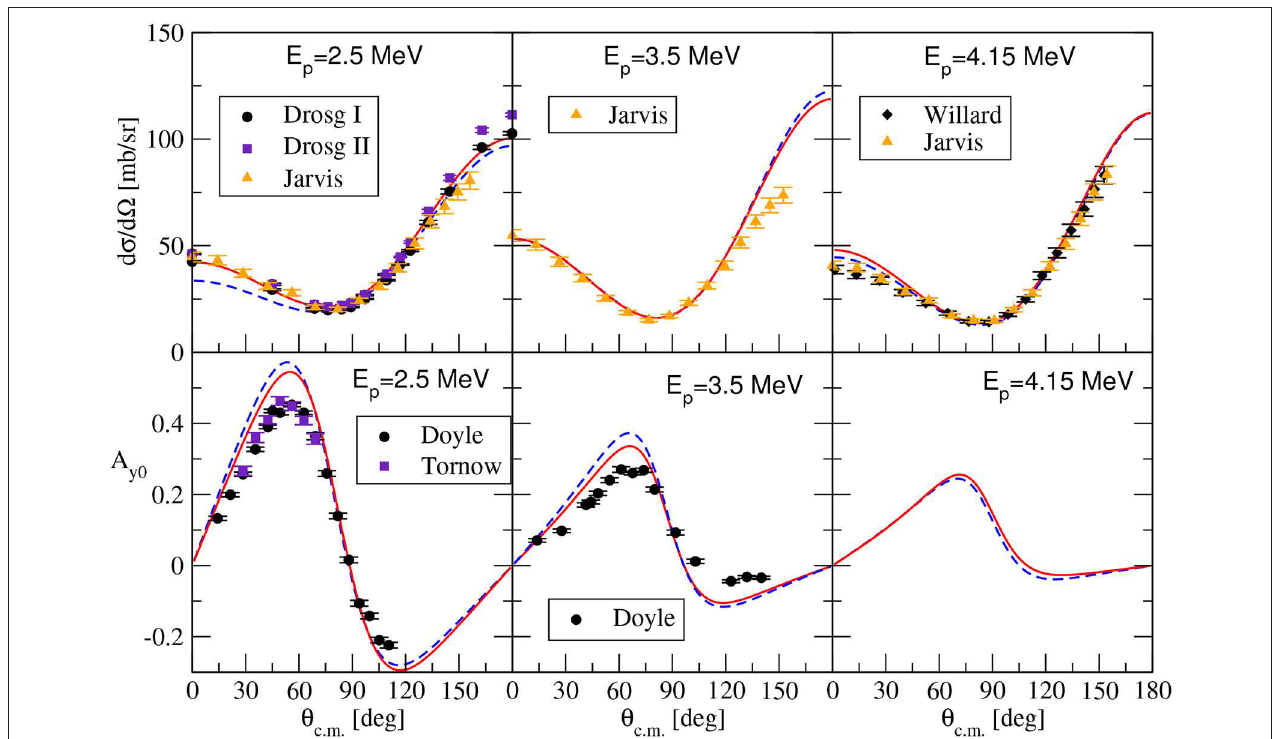
FIGURE 9 | p + 3 H → n + 3 He differential cross section and proton analyzing power at three values of the proton laboratory beam energy E p calculated with the N3LO-I (dashed blue lines) and with the N3LO-I/N2LO (solid red lines) interactions. The experimental data are from references